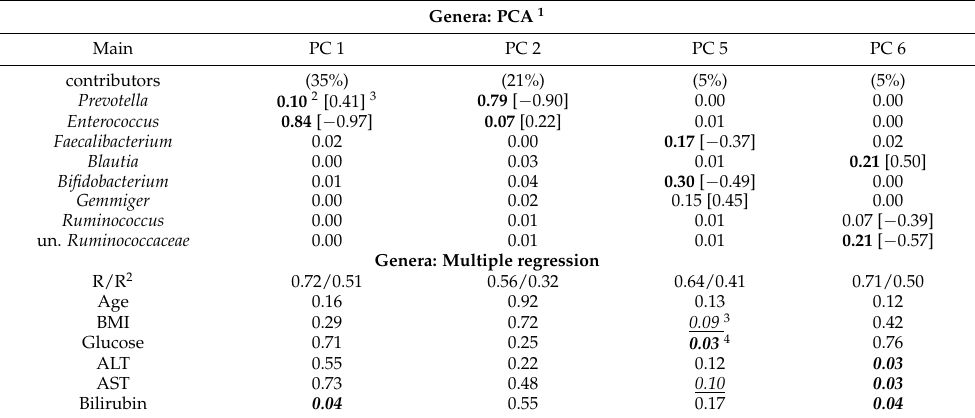
Table 3. Statistical analyses’ results: contribution of bacterial genera to the principal components extracted from the matrix with relative abundance in feces of females with gallstone disease before CCE (percentage of total variance in brackets) and p -values for multiple regression with blood biochemistry (coefficients of determination in brackets).